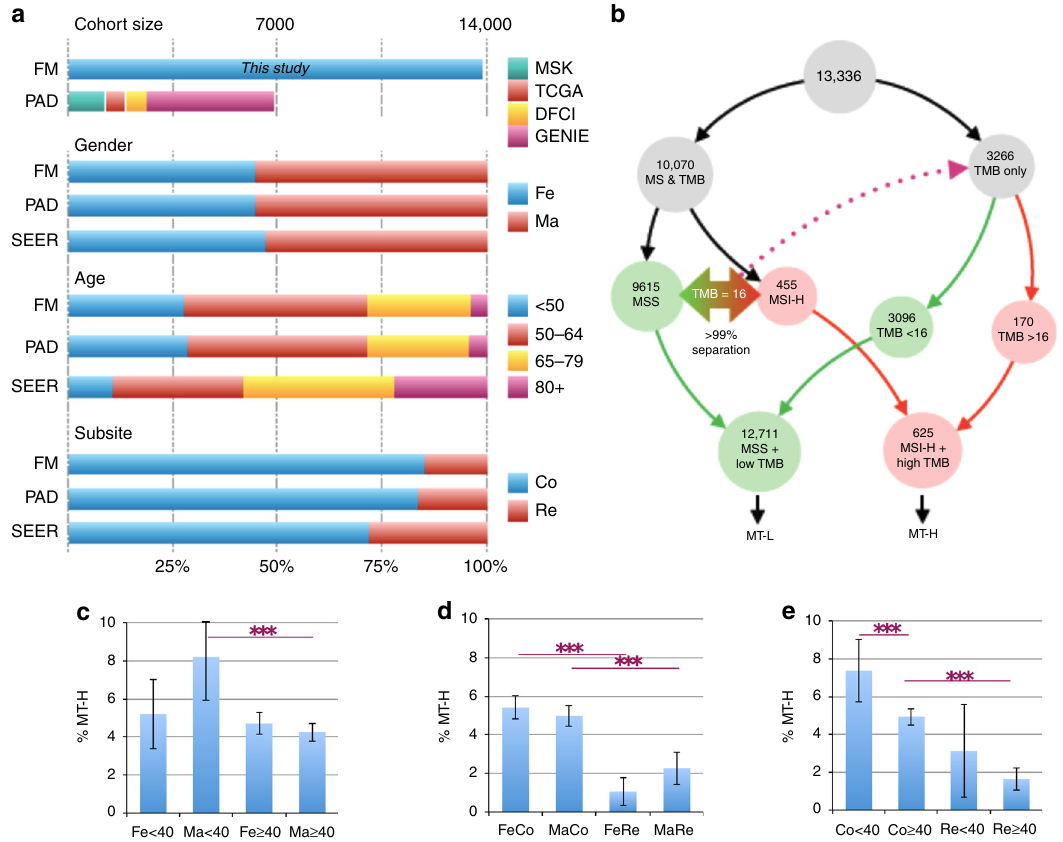
Fig. 1 Overall pro fi le of dataset. a Comparison of Foundation Medicine (FM) Inc. dataset in the present study versus a benchmark group of publicly available data (PAD) for colorectal cancer (CRC) published by Memorial Sloan-Kettering (MSK) 24 , the Dana Farber Cancer Institute (DFCI) 23 , the Genomics Evidence Neoplasia Information Exchange (GENIE) 25 , and The Cancer Genome Atlas (TCGA); population characteristics are also compared to overall population reported in SEER (Surveillance, Epidemiology, and End Results) 1 . b Flowchart and analysis tree for populations de fi ned by FM as high level of microsatellite instability (MSI-H) or microsatellite stable (MSS), or with known tumor mutation burden (TMB); generation of MSI-H/high TMB (MT-H) and MSI-H/low TMB (MT-L) analysis cohorts. c – e Frequency of MT-H tumors based on parameters of gender (Fe, female or Ma, male) as a factor of age (<40 or ≥ 40 years) ( c ), or primary tumor site (Co, colon or Re, rectum) ( d ); or in combined genders, based on age and tumor site ( e ). Error bars, 95% con fi dence intervals. Statistical signi fi cance is denoted by *** p <